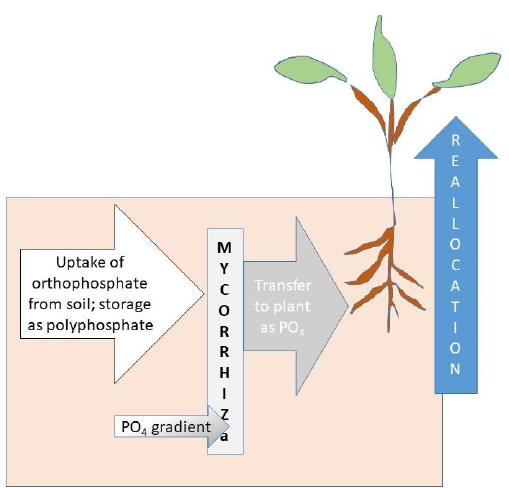
Figure 3. Multistep transfer of orthophosphate from soil through mycorrhizae to the plant.